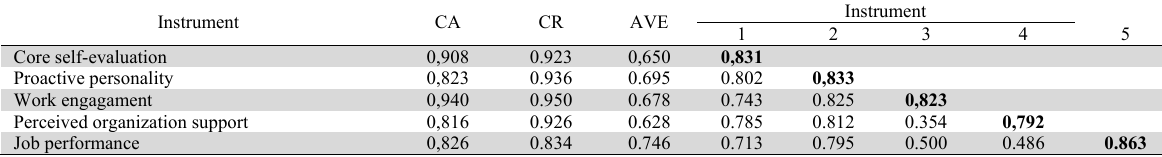
Convergent, Divergent Validity, and